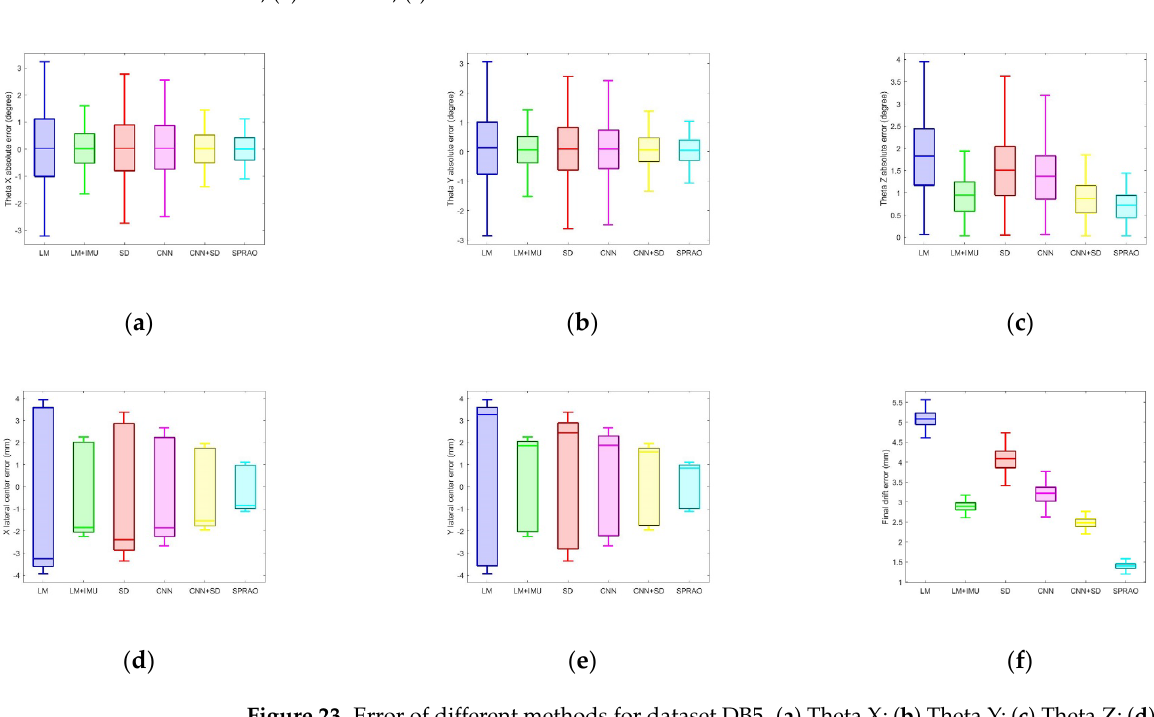
Figure 23. Error of different methods for dataset DB5. ( a ) Theta X; ( b ) Theta Y; ( c ) Theta Z; ( d ) Lateral X; ( e ) Lateral Y; ( f ) Drift.